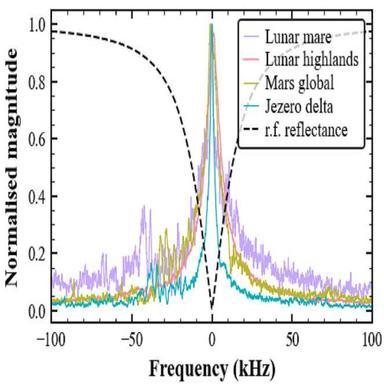
1 H spectrum obtained from a free induction decay measurement. The spectra are frequency shifted by the Larmor frequency, and the amplitudes are the magnitudes of the spectra, normalised to the maximum of the spectrum. The r.f. reflectance profile determined during tune and match measurements represents power not imparted on the sample.